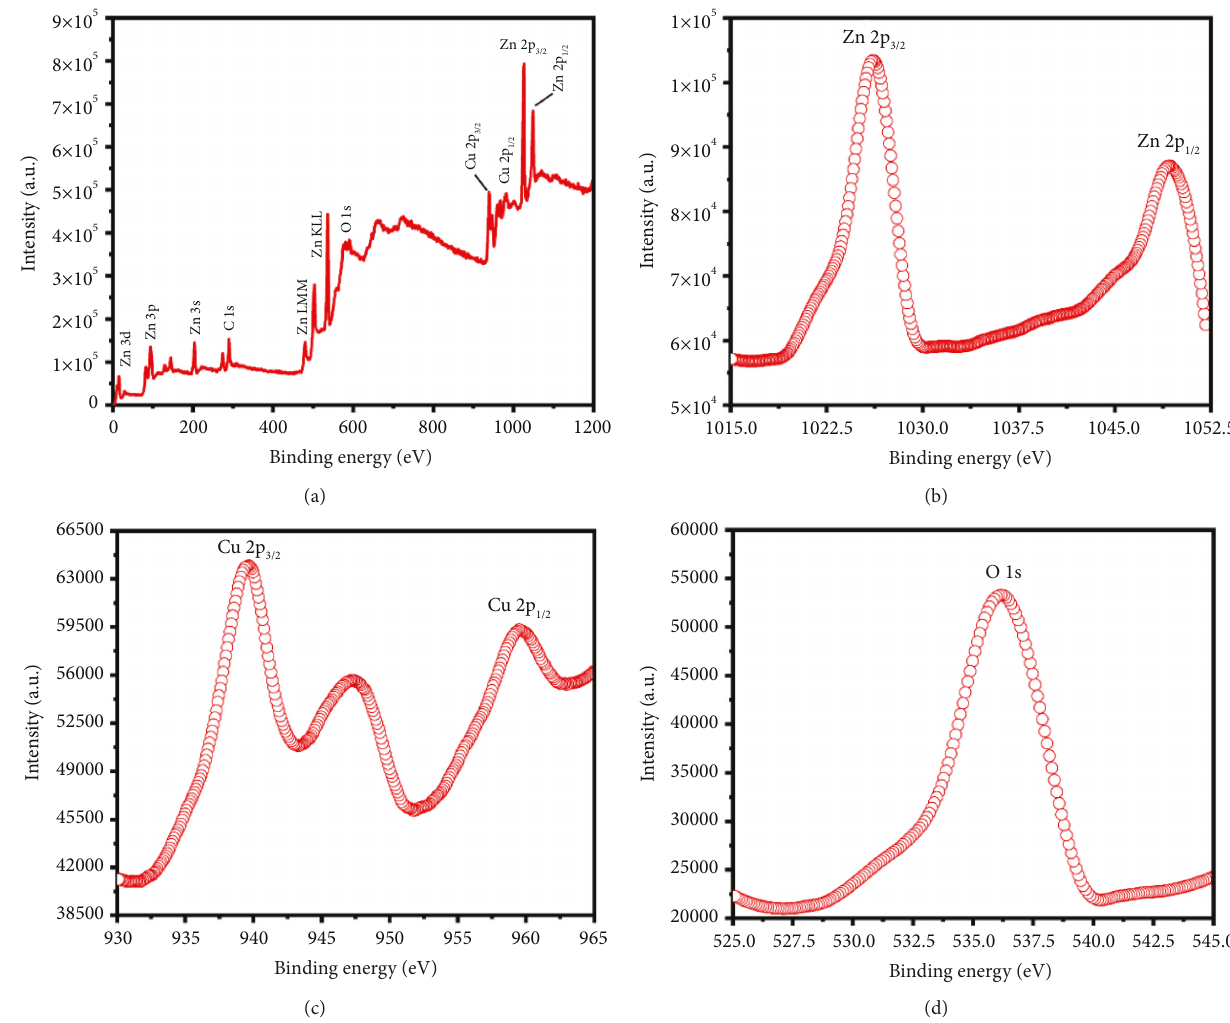
Figure 3: (a) XPS survey of Cu-doped ZnO NPs, (b) Zn 2p peaks (high resolution), (c) Cu 2p peaks (high resolution), and (d) O 1s